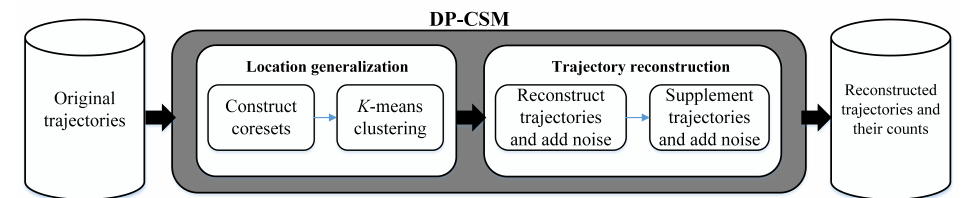
Figure 1. Framework of the DP-CSM. (The location generalization module utilizes coresets-based clus- tering to improve efficiency. The trajectory reconstruction module reconstructs synthetic trajectories with the generalized locations and uses the staircase mechanism to realize differential privacy.)